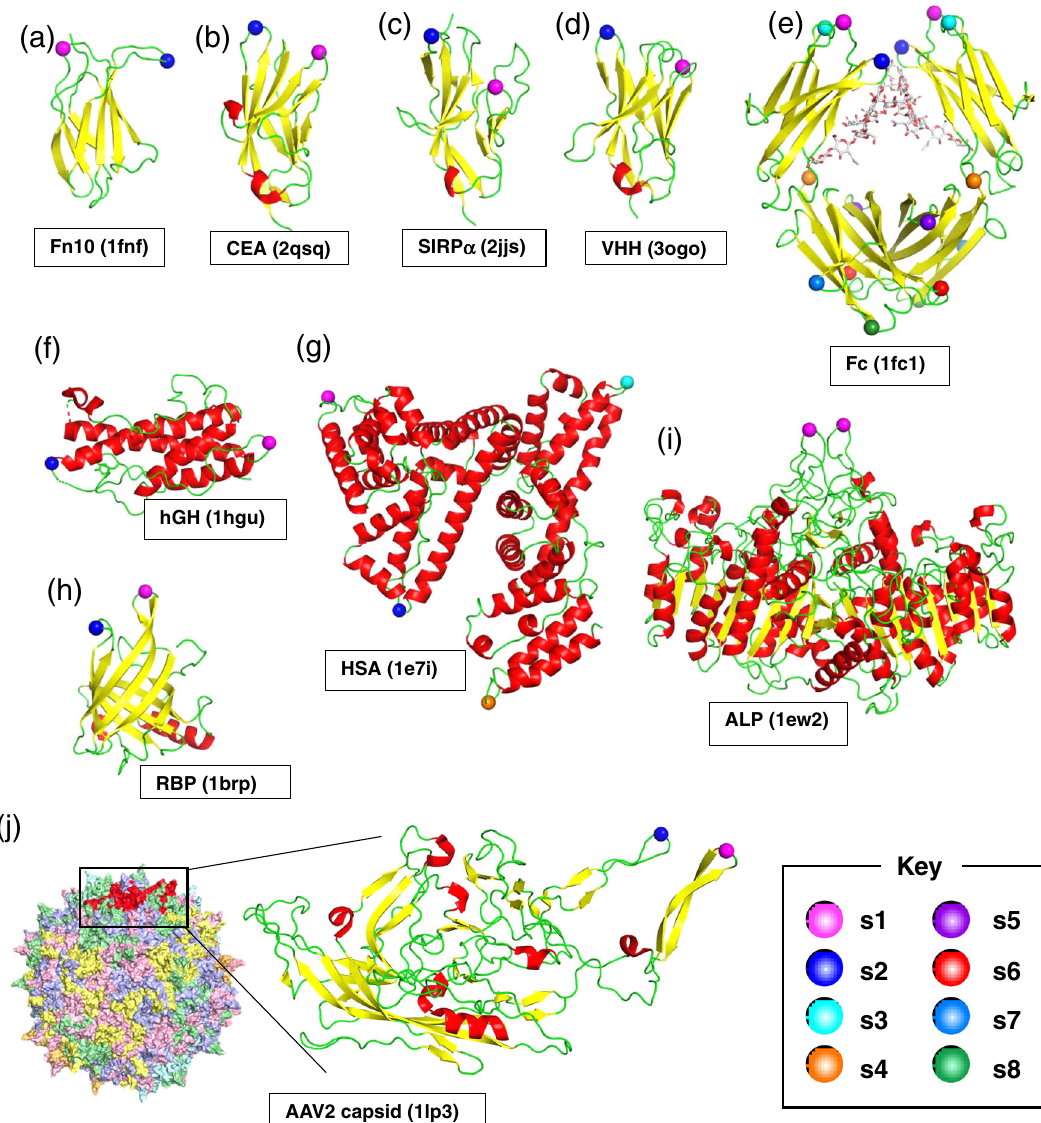
Fig. 2 Location of the peptide pharmacophore grafting sites. The structure of protein scaffold used for lasso-grafting are shown in cartoon representation: a fi bronectin 10th type-III domain (Fn10, PDB ID: 1FNF), b carcinoembryonic antigen (CEA, PDB ID: 2QSQ) 1st IgV domain, c signal regulatory